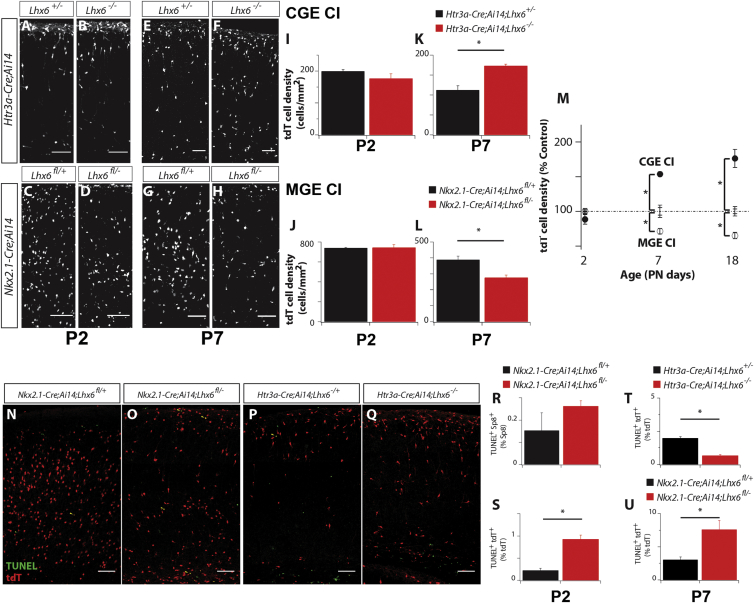
Reduced Apoptosis of CGE CIs Compensates for the Loss of Lhx6-Deficient MGE CounterpartsShown are changes in the number of CI subtypes in Lhx6 control and mutant mice during early post-natal development.(A–H) tdT-expressing CIs in cortical sections from P2 (A–D) and P7 (E–H) Lhx6 control (A, C, E, and G) and mutant (B, D, F, and H) mice. tdT expression identifies CGE-derived (A, B, E, and F) and MGE-derived CIs (C, D, G, and H), respectively.(I–L) Quantification of the distribution of tdT+ cell density in the cortex of P2 (I and J) and P7 (K and L) for CGE (I and K) and MGE (J and L) derived CIs.(M) Summary of changes in density of CGE (closed circles) and MGE (open circles) CIs in Lhx6 mutant cortices relative to Lhx6 controls (dotted line) at P2, P7, and P18.(N–Q) Representative cortical sections from P7 somatosensory cortices showing fate-mapped CIs (tdT+ in red) and TUNEL+ (green) cells. Yellow arrowheads indicate TUNEL+ fate mapped CIs. In (N) and (O), tdT expression represents MGE-derived CIs, whereas in (P) and (Q), tdT represents CGE-derived CIs.(R and S) Quantification of TUNEL+ cells for CGE-derived CIs (R; Sp8+TUNEL+) and MGE-derived CIs (S; tdT+TUNEL+) at P2 for control and Lhx6 mutant cortices.(T and U) Quantification of TUNEL+ cells for CGE-derived (T) and MGE-derived (U) CIs undergoing apoptosis (tdT+TUNEL+) at P7 for control and Lhx6 and mutant cortices.See Figure S4 for characterization of proliferation and migration of CI precursors in embryonic Lhx6 mutant brains. Scale bars are 100 μm.